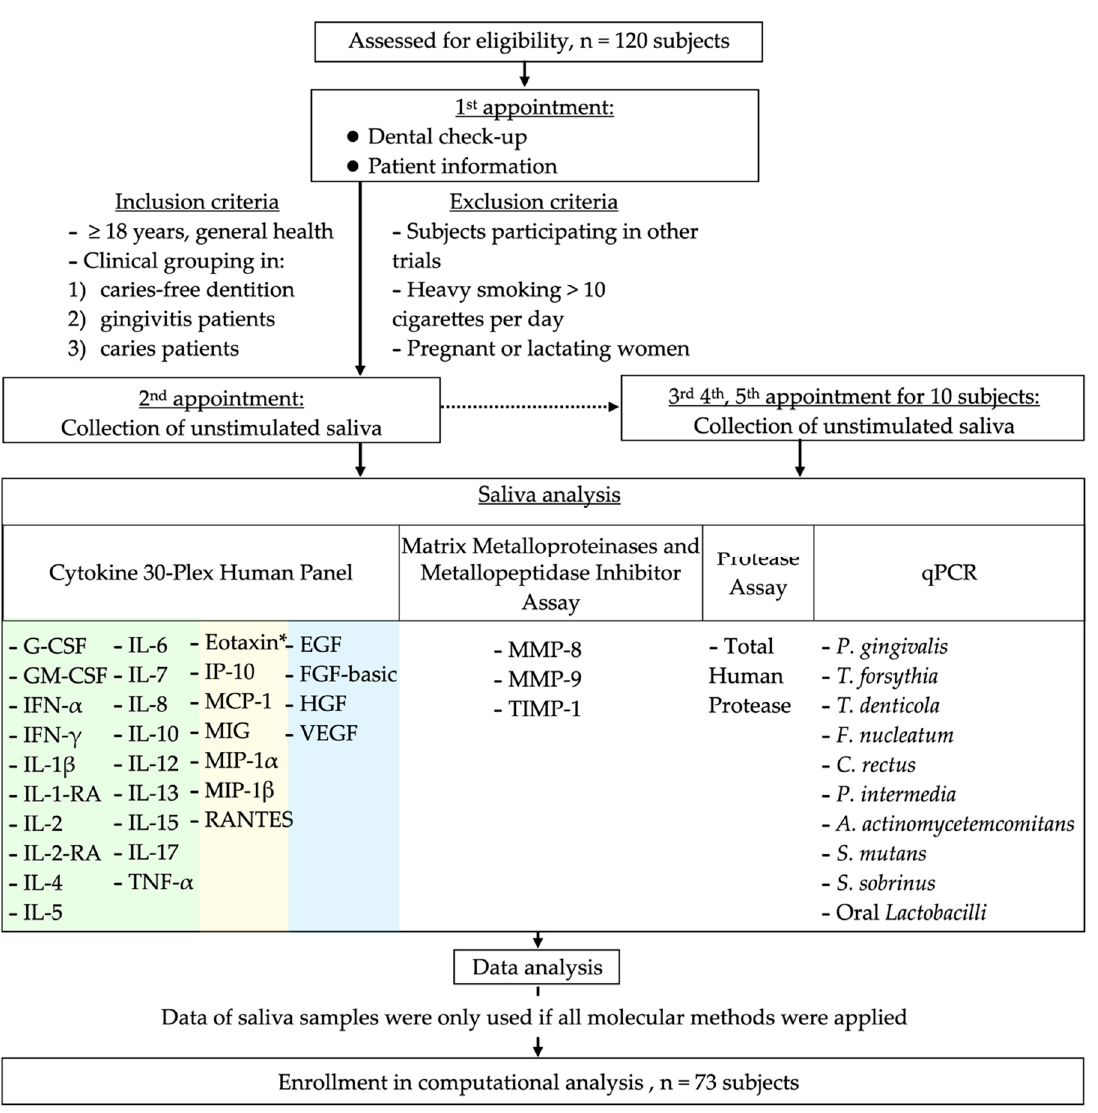
Figure 1. Flow-chart showing the study design, study population, and applied saliva analyses. Biomarkers of the Cytokine 30-Plex Human Panel are color-coded for cytokines (green), chemokines (yellow), and growth factors (blue). * Eo-taxin/CCL11.